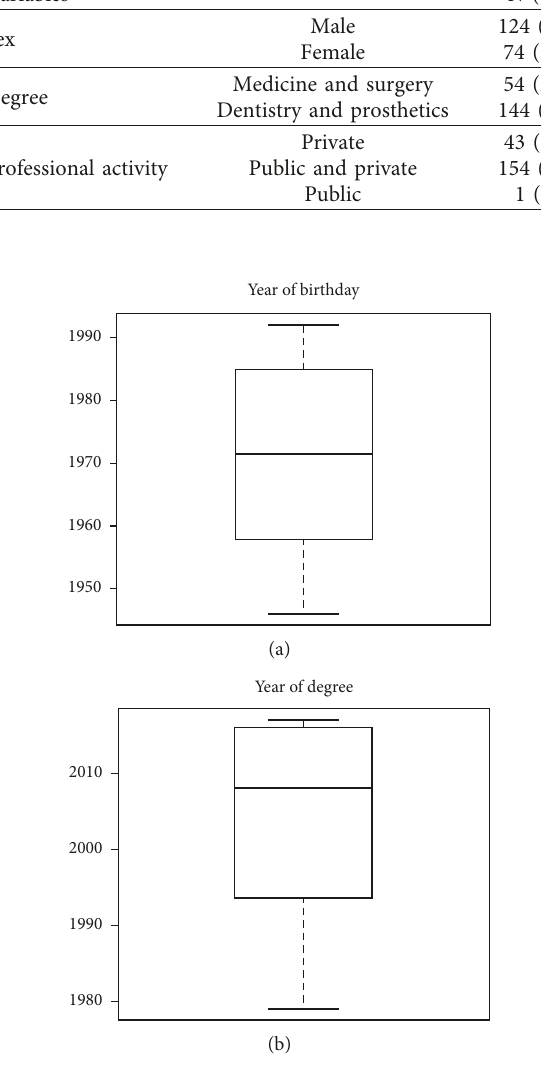
Figure 2: Boxplots of (a) year of birthday and (b) year of degree that shows a symmetric and an asymmetric distribution of the two variables, respectively.